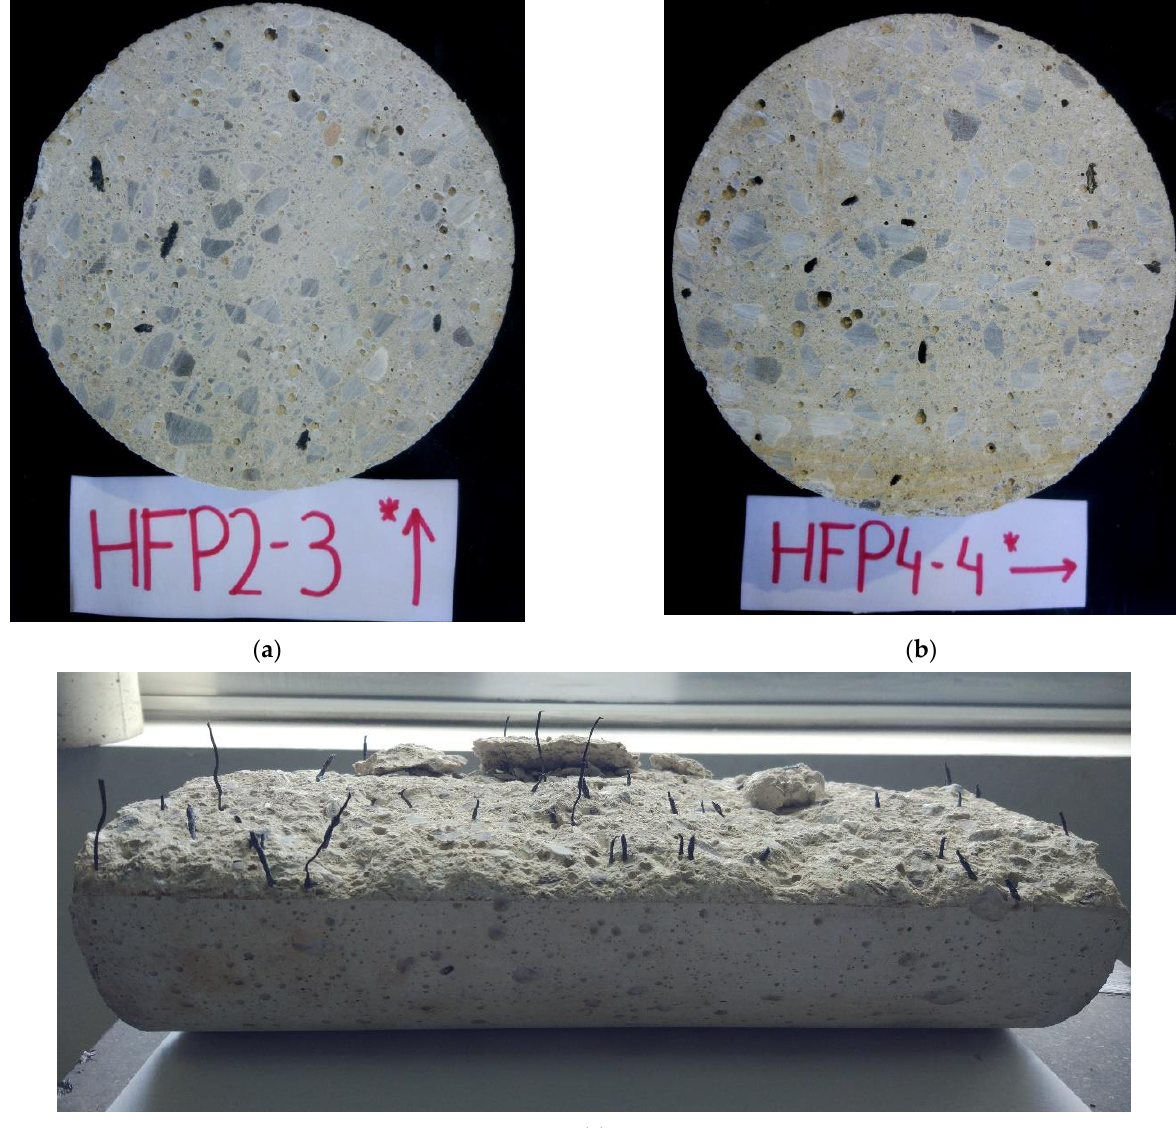
Figure 16. Examples of fibre distribution ( a ) and ( b ) and the orientation of fibres ( c ).